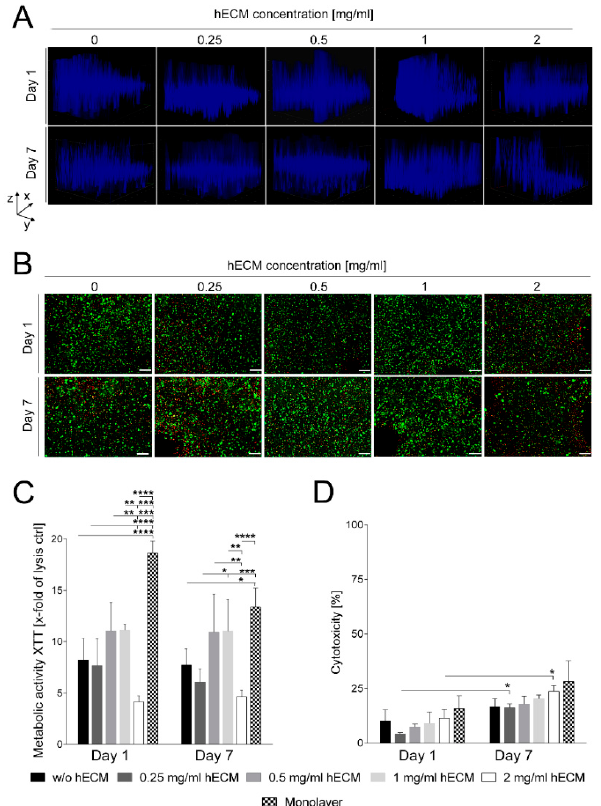
Figure 2. Spatial distribution and viability of mature HepaRG cells in 3D printed alginate/gelatin constructs with varying hECM concentrations. ( A ) Three-dimensional distribution of mature HepaRG cells in 3D printed constructs one and seven days after printing visualized by nuclear Hoechst staining (blue) and Z-stack analysis from the top of the gel to the dish surface (scanning depth 1000 µm, interval 15.12 µm, area 1800 × 1400 µm). 3D models were recorded with the Z-stack tool, which creates a projection of the transmitted light. Figure A shows representative images of the bioprinted 3D models carried out as three independent experiments; ( B ) Qualitative viability staining of living and dead mature HepaRG cells printed in the constructs after one and seven days of cultivation using calcein-AM (live in green) and ethidium homodimer-1 (dead in red). Scale bar: 200 µm; ( C ) Metabolic activity of mature HepaRG cells in different 3D printed alginate/gelatin/hECM bioinks was determined by the tetrazolium hydroxide salt (XTT) assay one and seven days after printing. Values were calculated as X-fold induction of lysis control; ( D ) Cytotoxicity was analyzed by the lactate dehydrogenase (LDH) assay. Data are depicted as percentage of the LDH level of cells in 3D printed constructs relative to the lysis control. For C and D, data from monolayer cultures are shown for comparison. Results are shown as mean ± standard error of the mean (SEM) of three independent experiments. * p ≤ 0.05; ** p ≤ 0.01; *** p ≤ 0.001; **** p ≤ 0.0001.